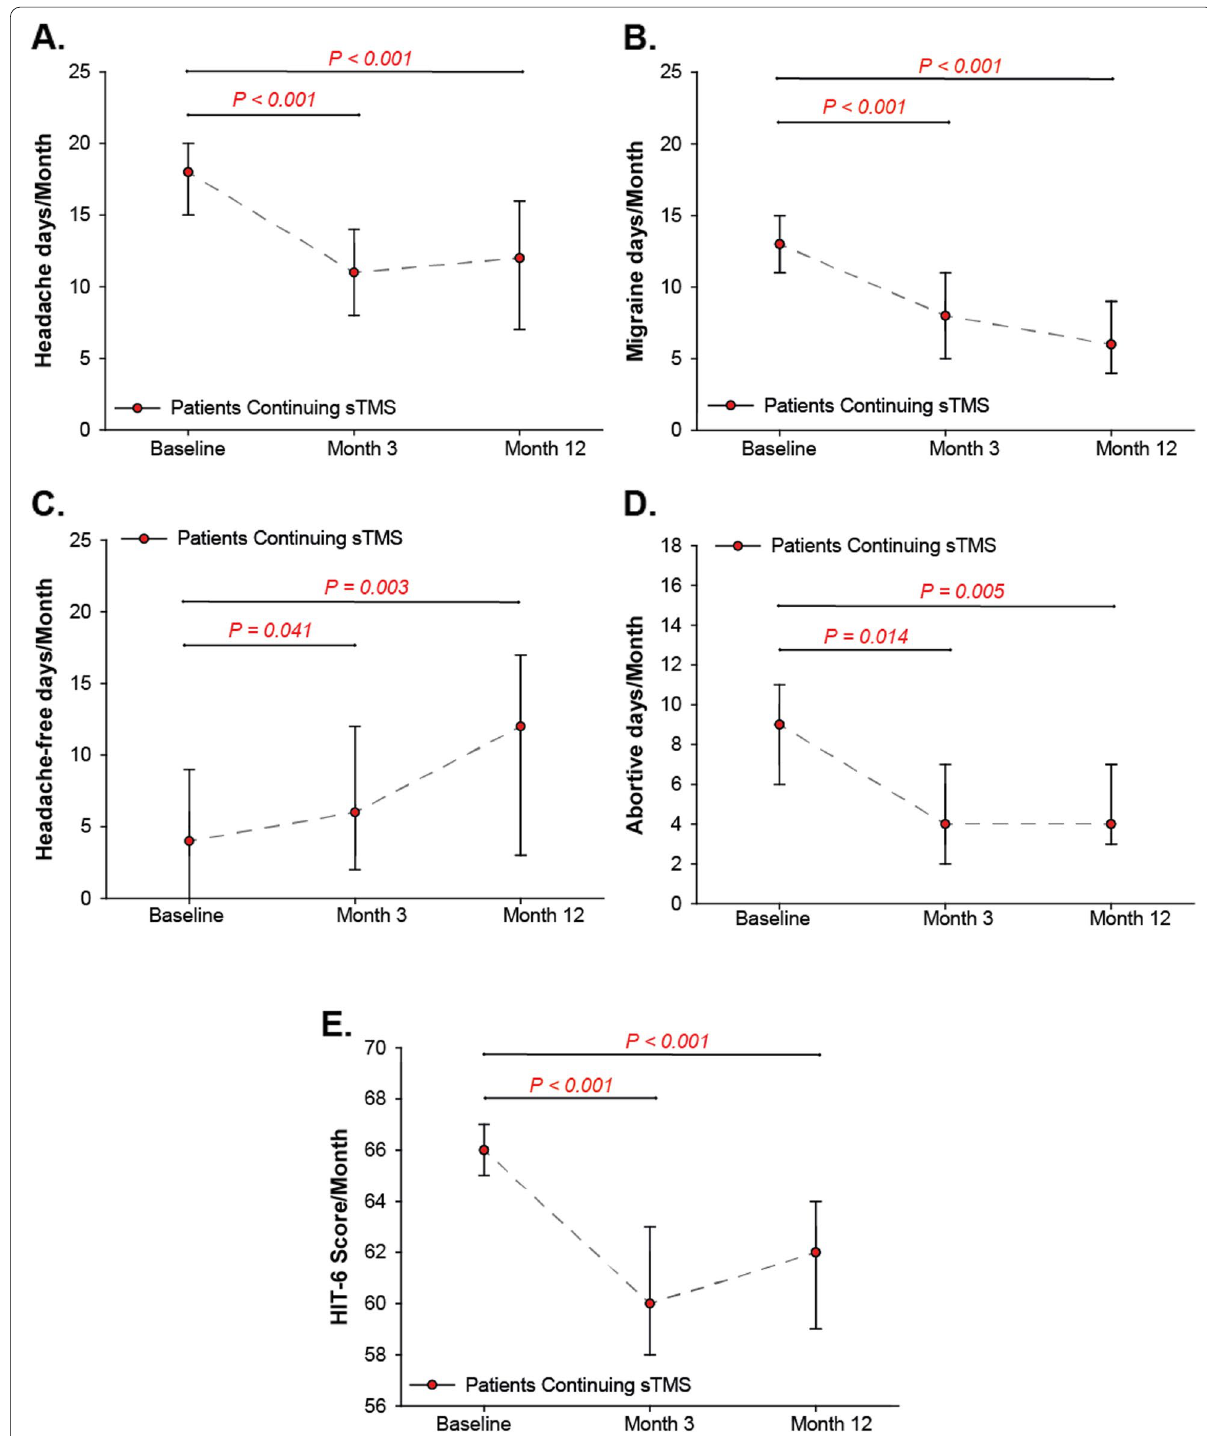
Fig. 3 Effectiveness outcomes of patients continuing to use single‑pulse transcranial magnetic stimulation at baseline and at 3 and 12